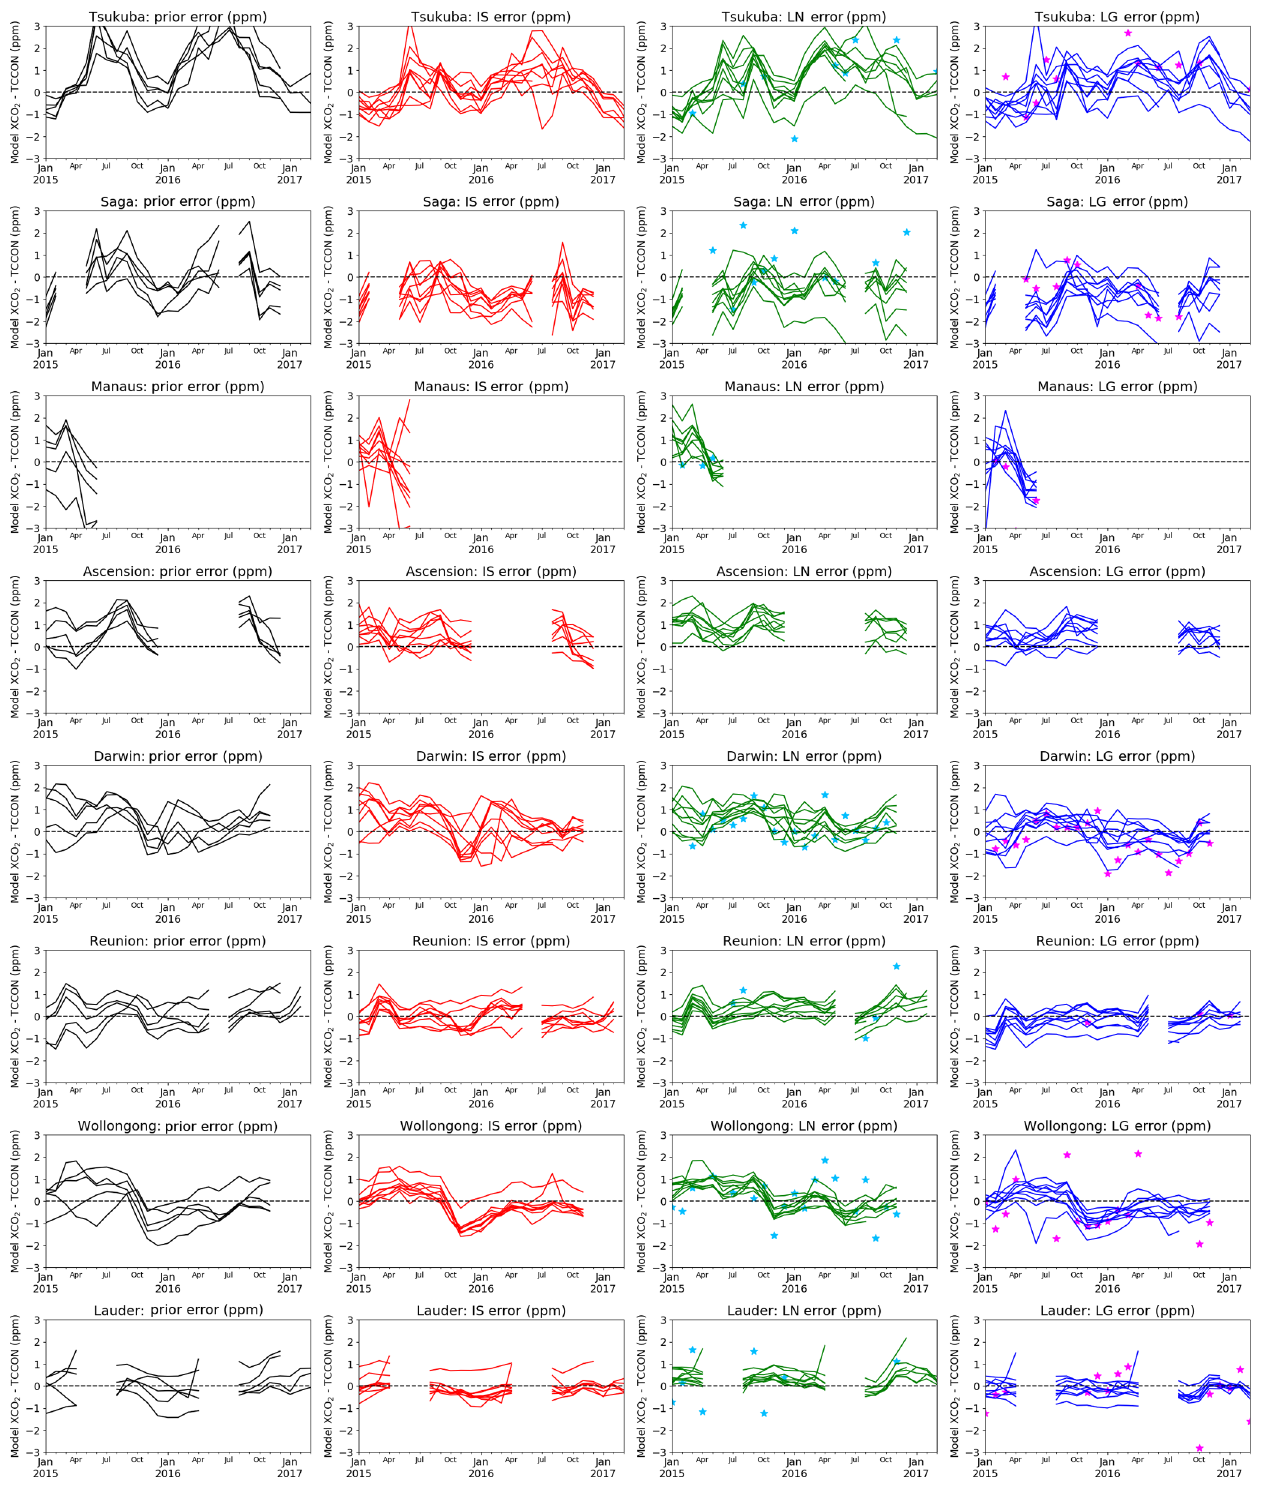
Figure C4. As in Fig. C2, but for sites in Japan, the tropics, and the Southern Hemisphere.